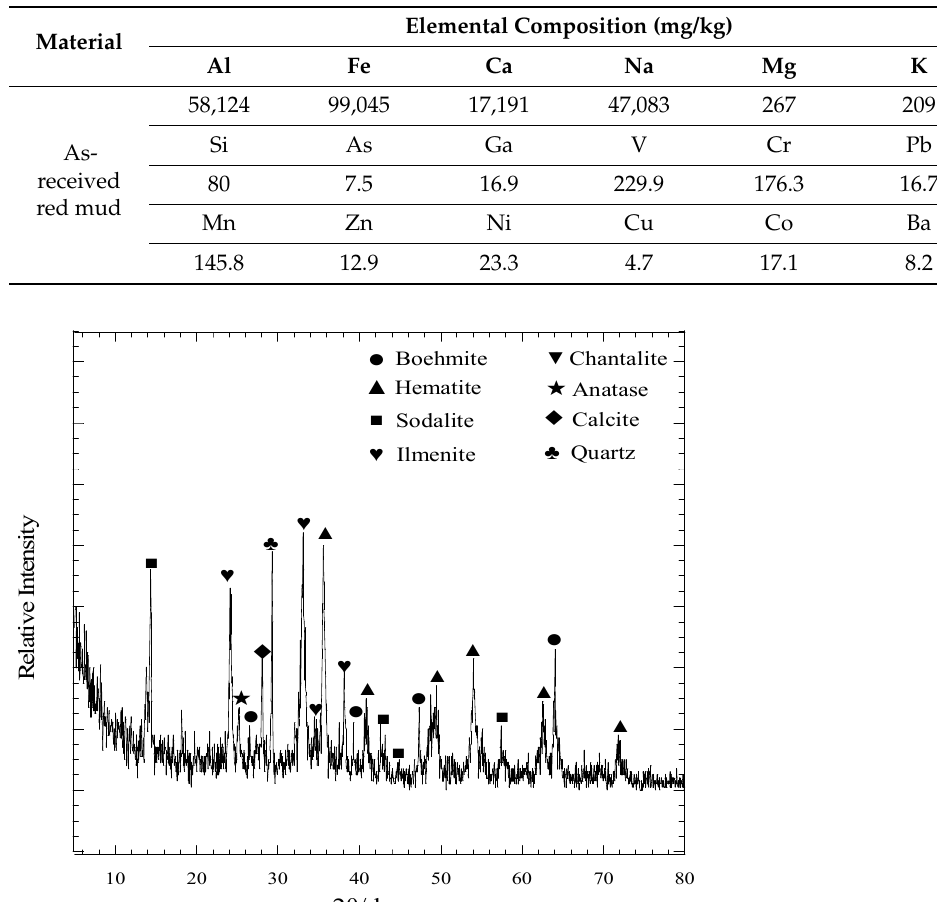
Table 1. Results of total elemental analysis for the as-received red mud.